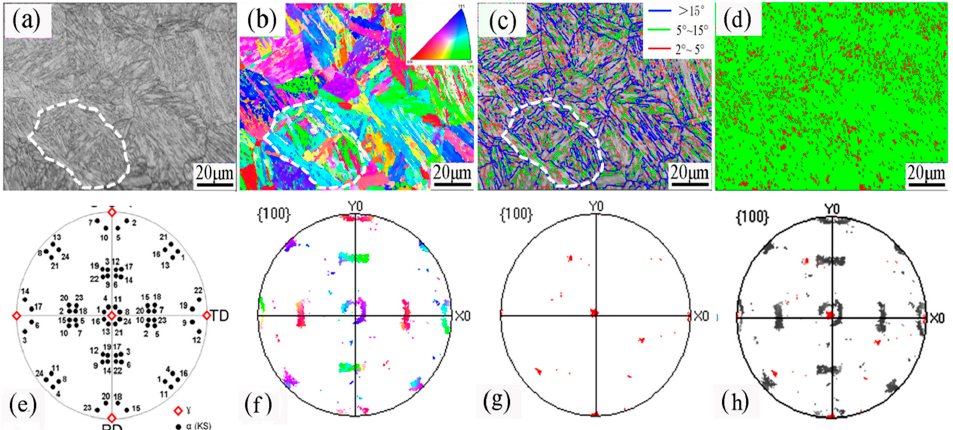
Figure 9. Crystallographic orientation maps of the experimental steel tempered at 600 °C for 16 h. ( a ) The band contrast map; ( b ) the colored inverse pole figure of the map; ( c ) boundary map; ( d ) the phase distribution map and ( e ) standard (100) pole projections of a 24 possible K-S martensite variants originating from single (001) [100] austenite orientation. ( f ) (100) Pole figure of the martensite in the selected one prior austenite grain; ( g ) (100) pole figure of the reverted austenite in the selected one prior austenite grain and ( h ) (100) pole figure combining the martensite with reverted austenite in the selected one prior austenite grain.